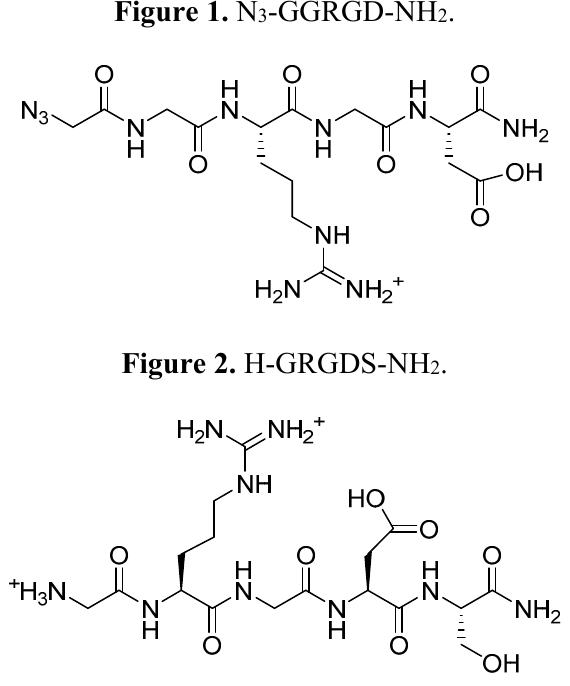
Figure 1. N 3 -GGRGD-NH 2 .